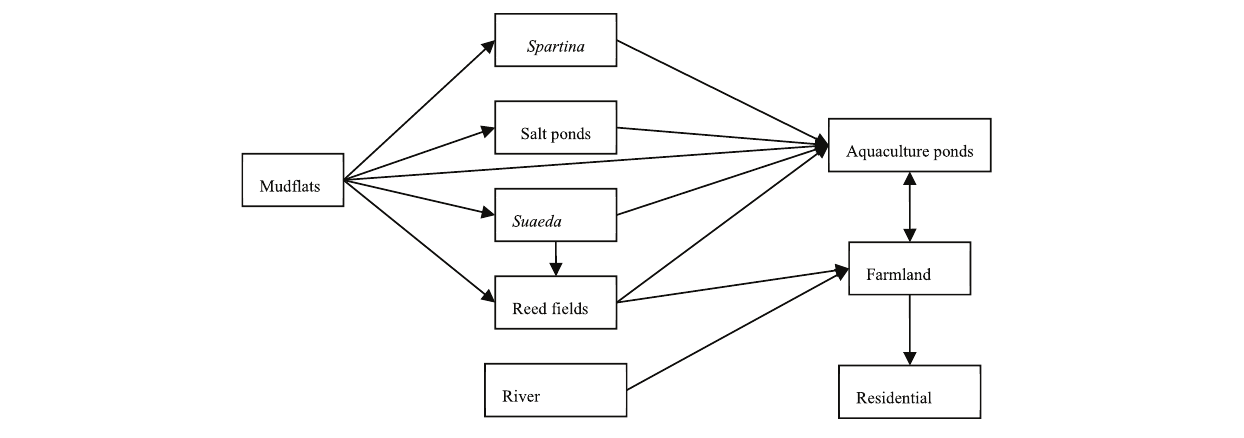
FIGURE 6 | Succession of main landscapes in Yancheng